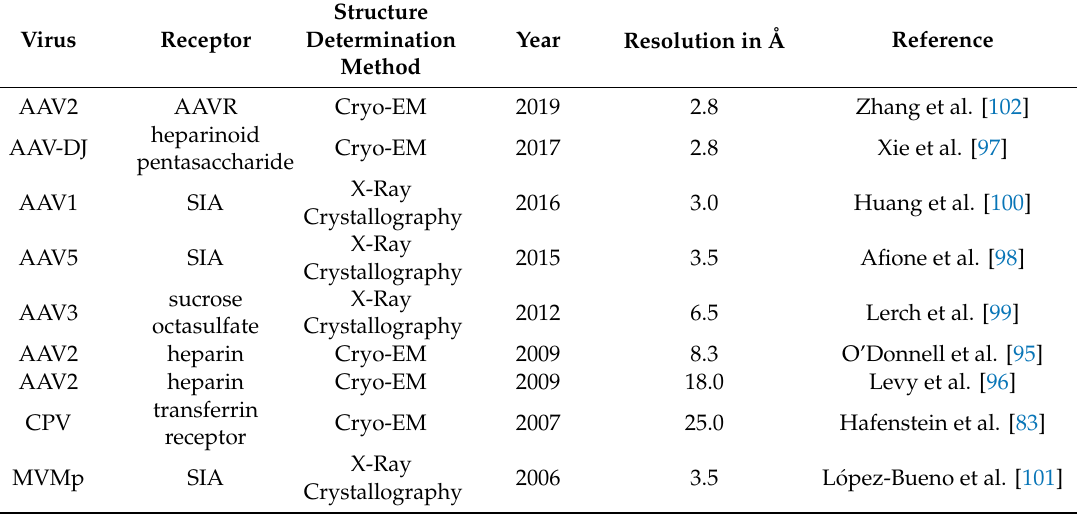
Table 3. Summary of published Parvovirinae capsid-receptor complex